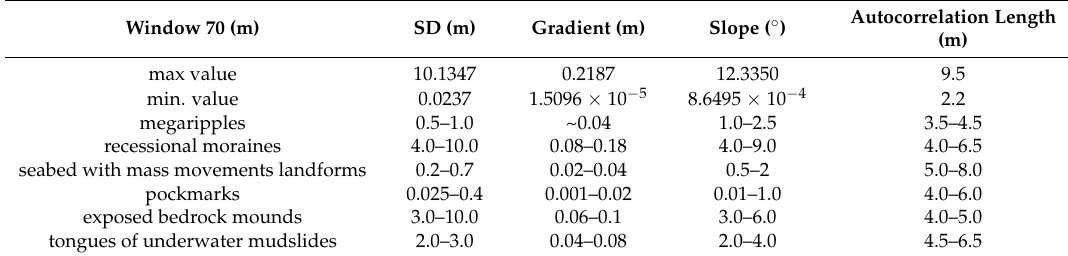
Table 1. Values of statistical parameters for the main morphological forms of Hansbukta